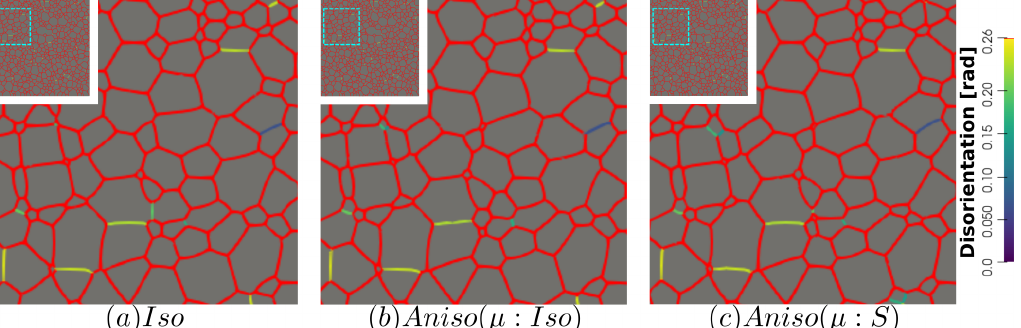
Figure 11. Disorientation distribution obtained excluding TBs at ( a ) t = 1 h and ( b ) t = 2 h for the isotropic (Iso) formulation, anisotropic formulations with isotropic GB mobility (Aniso( µ :Iso)), and heterogeneous GB mobility (Aniso( µ :S)) and the experimental data (EBSD). The Y-axis represents the GB length percentage.